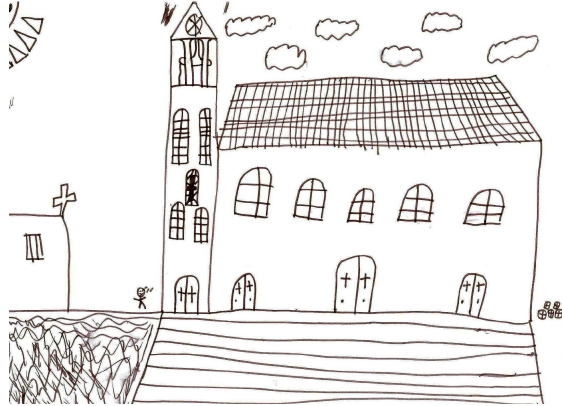
Figure 3. Expectation drawing of a church.